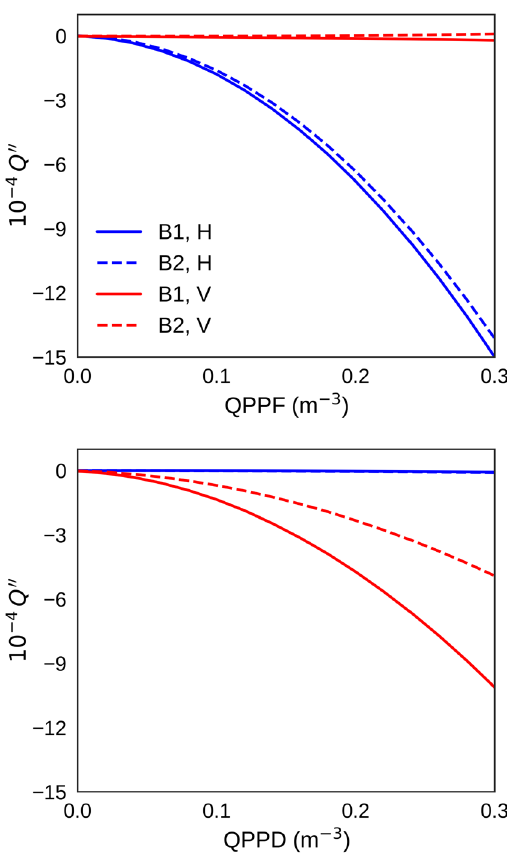
FIG. 2. Q 00 predicted by MAD - X for the two beams ( B 1 and B 2 ) for the horizontal ( H ) and the vertical ( V ) planes as a function of the QPPF (top) and QPPD (bottom) sextupole knobs,